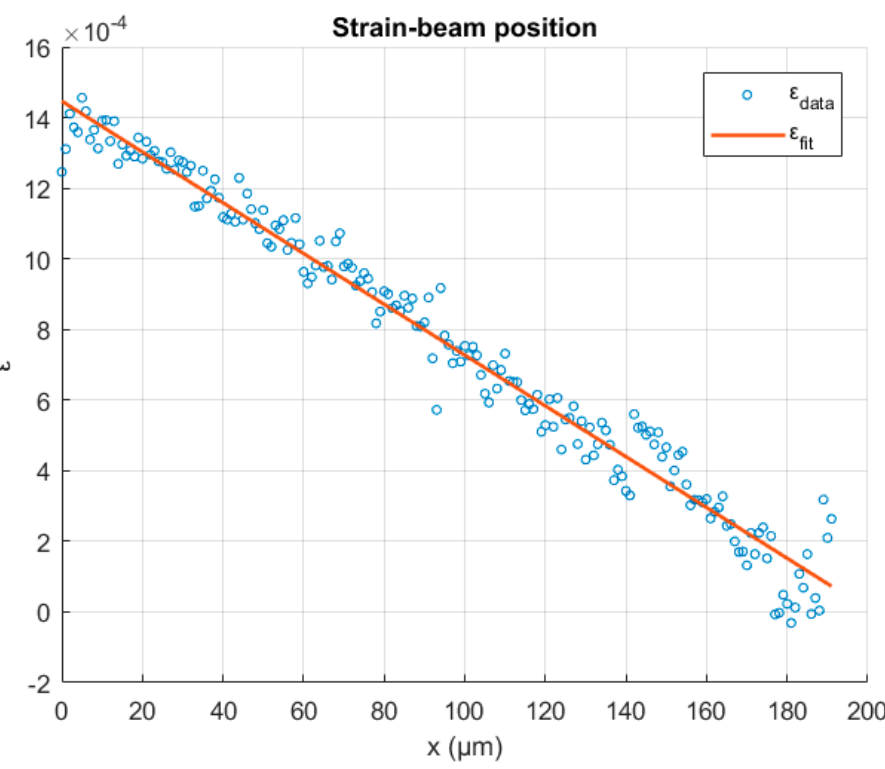
Figure 3. The AFM cantilever bending strain as calculated from the Raman shift and the fitted linear regression of data.